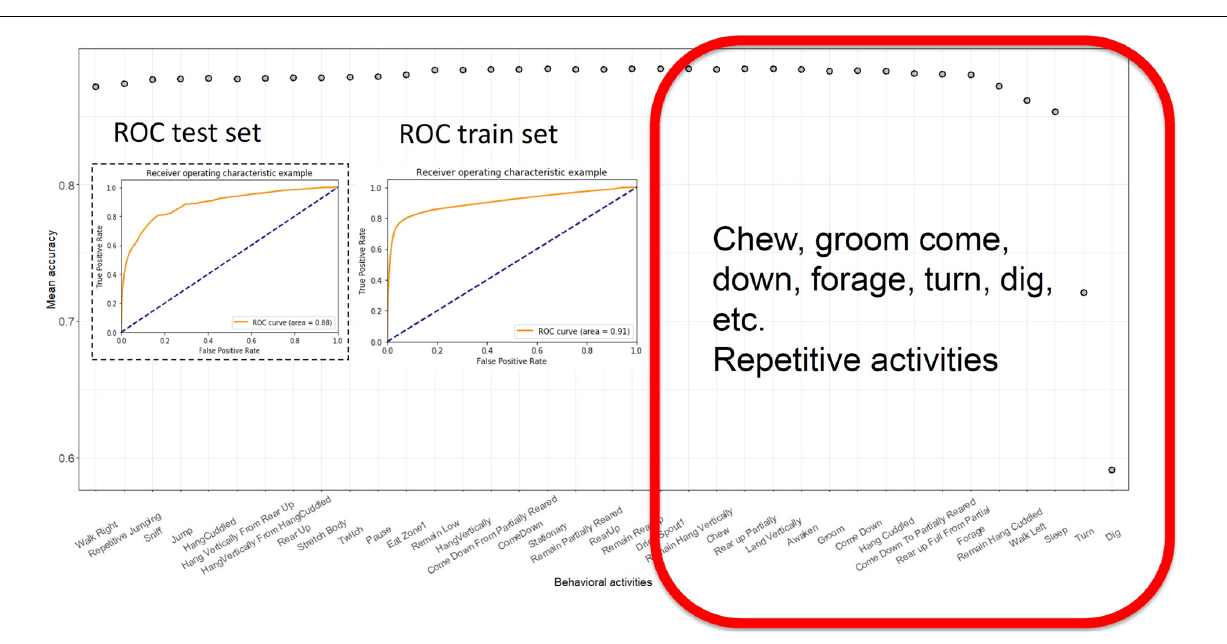
FIGURE 3 | Backward feature elimination using LG. Each prediction model was computed, dropping the most irrelevant or confounding feature and least successful model was eliminated. Ultimately, when a few features remained, the models performance started to decline. The ROC curves of test and training sets with most successful model with least number of features. The red square contains a list of features that contribute the most to accuracy of the